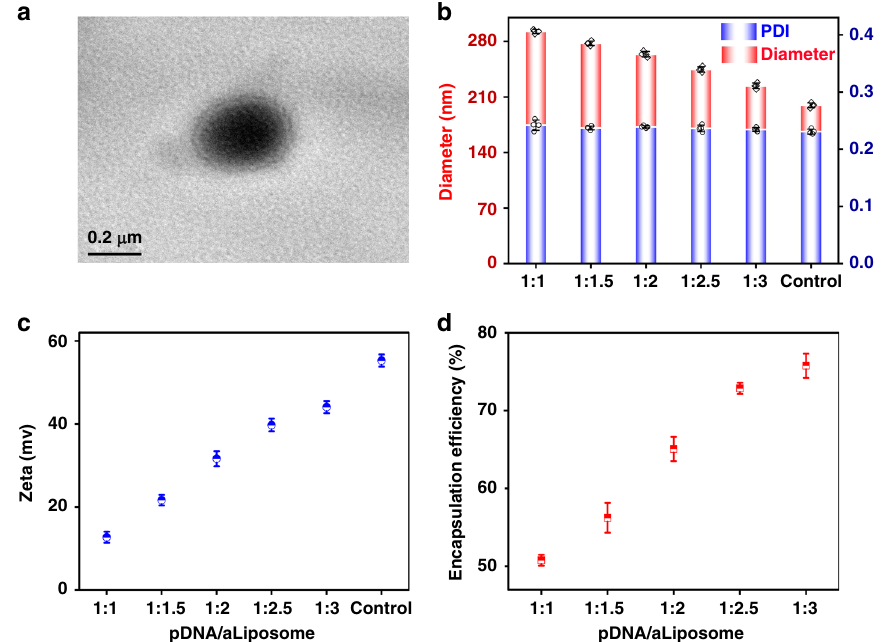
Fig. 2 Aldehyde cationic liposomes loading different ratios of pDNA. a The TEM image of blank aldehyde cationic liposomes (scale bar was 0.2 µ m, 5 independent experiments). b Particle size distribution and PDI of aLiposome loading different ratio of pDNA ( n = 4, size distribution and PDI values were mean ± std. dev.). c The surface charge of aLiposome loading different ratio of pDNA ( n = 3, surface charge values were mean ± std. dev.). d The encapsulation ef fi ciency of different ratio of pDNA/aLiposome ( n = 3, encapsulation ef fi ciency values were mean ± std.